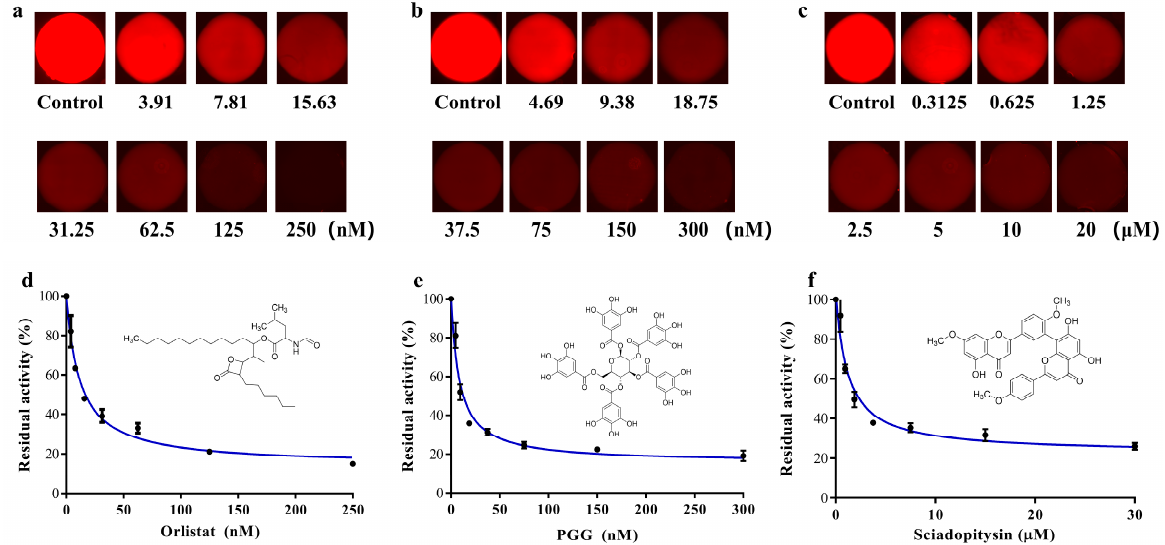
Figure 5. ( a – c ) Fluorescence pictures of Orlistat, PGG and sciadopitysin, with seven gradient con- PGG and sciadopitysin against hPL-catalyzed DDAO-ol hydrolysis. Inserts illustrated the